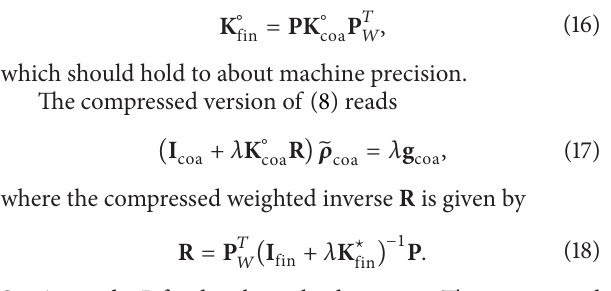
both belong to the boundary segment Γ ⋆ are retained. The remaining entries are